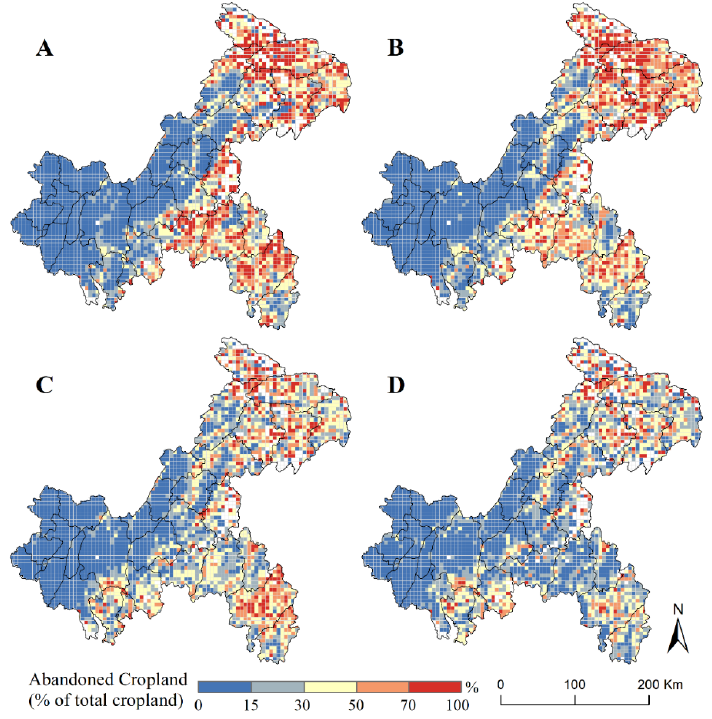
Figure A3. Average cropland abandonment rates within 5 km grid squares in Chongqing for ( A )